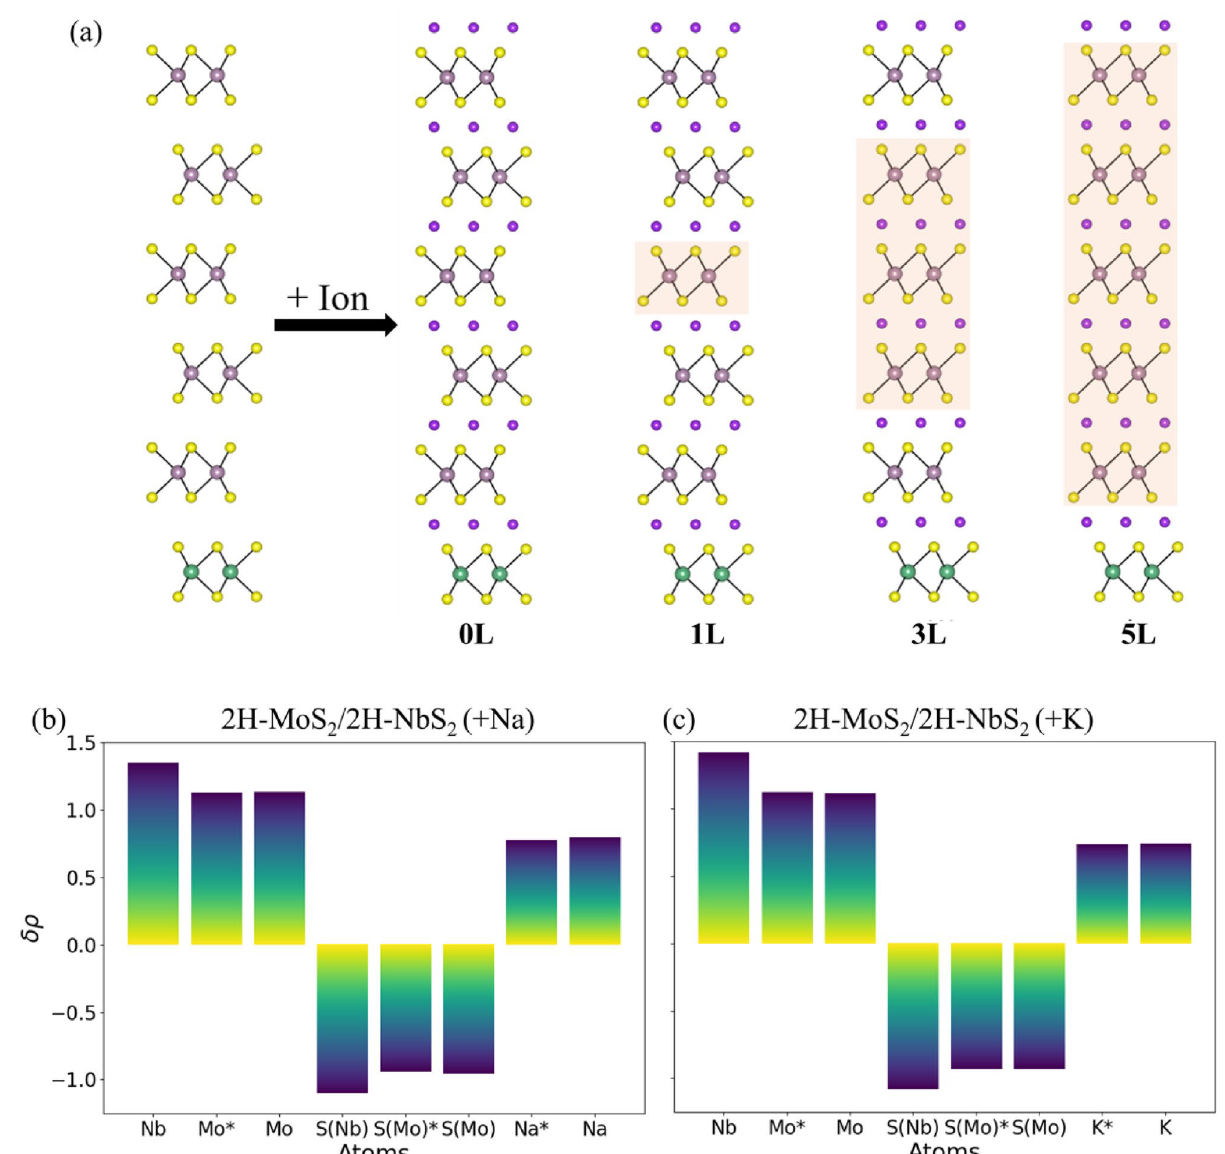
Figure 5. ( a ) (left) Schematic representation of the 5-MoS 2 /1-NbS 2 heterostructures showing a repeating unit of five MoS 2 layers and one NbS 2 layer. Light purple, green, yellow, and darker purple spheres represent Mo, Nb, S, and intercalating ions- Na or K, respectively. 1T-MoS 2 is highlighted in orange. Charges transferred from different atoms in ( b ) Na-ion intercalated and ( c ) K-ion intercalated lowest energy structure 0L: 2H-NbS 2 /2H- MoS 2 computed using Bader analysis. A positive value implies that the atom lost electrons, while a negative value indicates that the atom gained electrons. S(Mo) identifies S atoms bonded to Mo, while S(Nb) refers to S atoms bonded to Nb atoms. Asterisks (*) are marked to identify Mo and S(Mo) atoms neighboring NbS 2 layers and Na- or K-ions intercalating the interface between NbS 2 and MoS 2 .